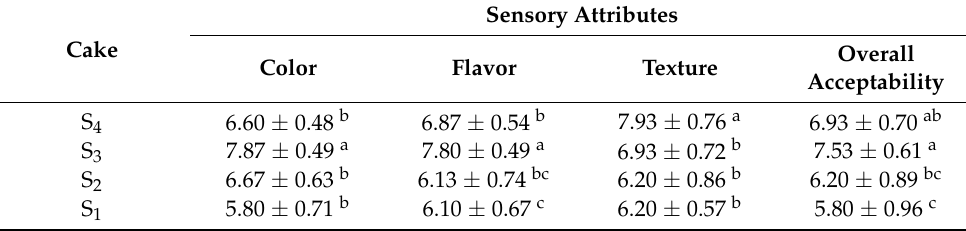
Table 6. Effect of addition of Aloe Vera leaf powder (ALP) on sensory attributes of plain cakes.